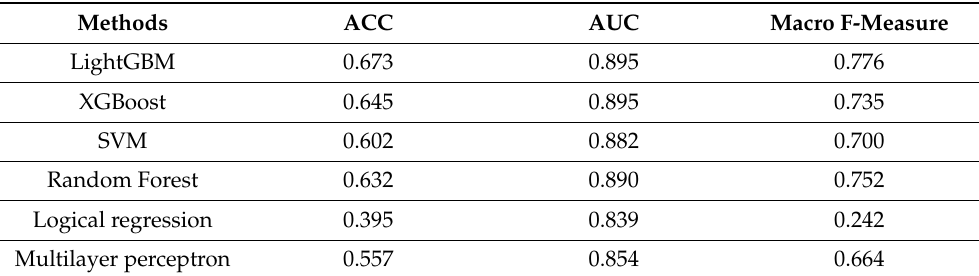
Table 3. Performance of different machine learning algorithms with feature PSTNPSSMC under 5-fold cross-validation.